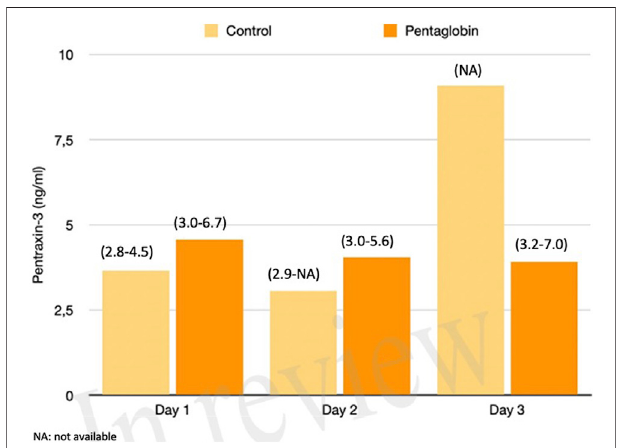
FIGURE 5 | Comparison of Presepsin changes over time between Pentaglobin and control groups by linear mixed models ( p (cid:1) 0.20). The height of bars represents the median values and the numbers in brackets the corresponding interquartile range in Pentaglobin treated patients and in controls. Presepsin wasmeasuredfor the fi rst 3 days from diagnosisofseptic shockandthe fi gureshowsdecreaseinitsconcentrationof25%fromday1to day 2 in the Pentaglobin group, whilst the decrease was slightly lower in the control group. The between-groups comparison over time was performed by linear mixed models and resulted to be not signi fi cant ( p (cid:1) 0.20). See text for more